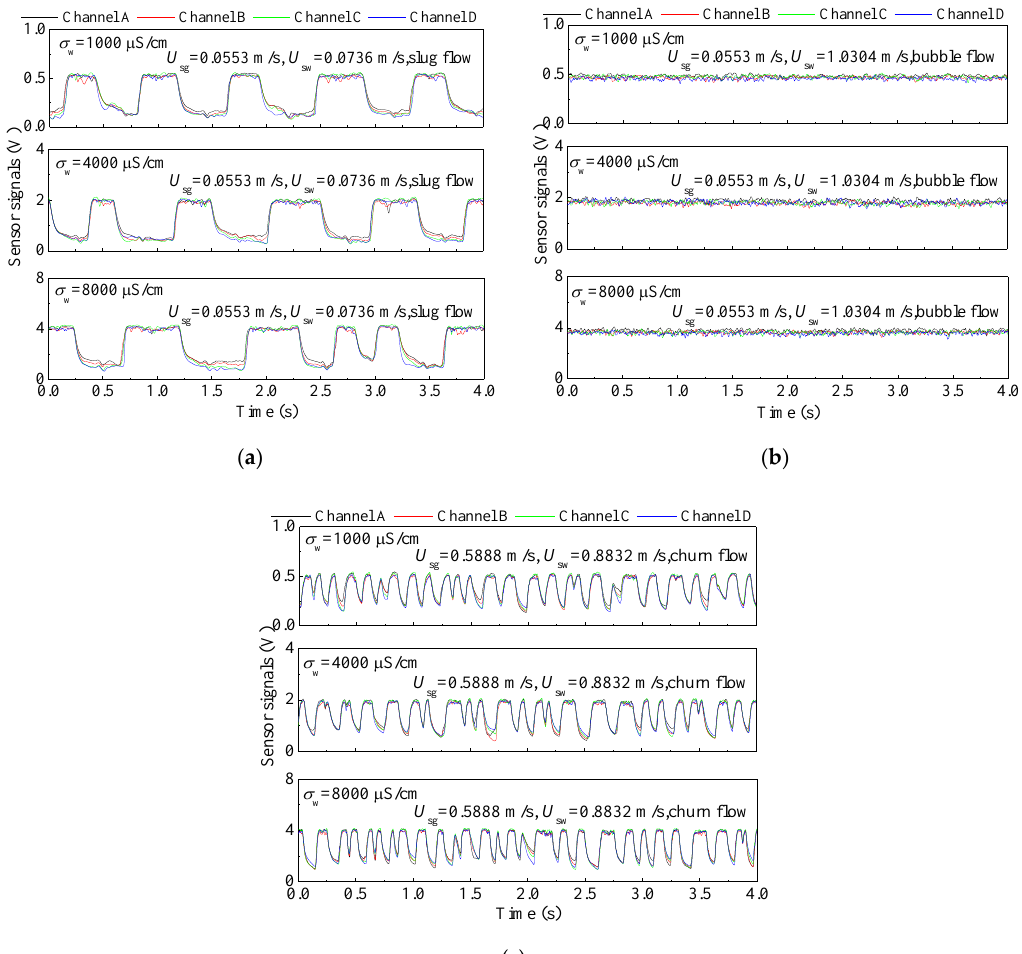
Figure 6. The sensor outputs of the water holdup sensor under different flow patterns with different water conductivities: ( a ) The outputs for slug flow; ( b ) The outputs for bubble flow; ( c ) The outputs for churn flow.